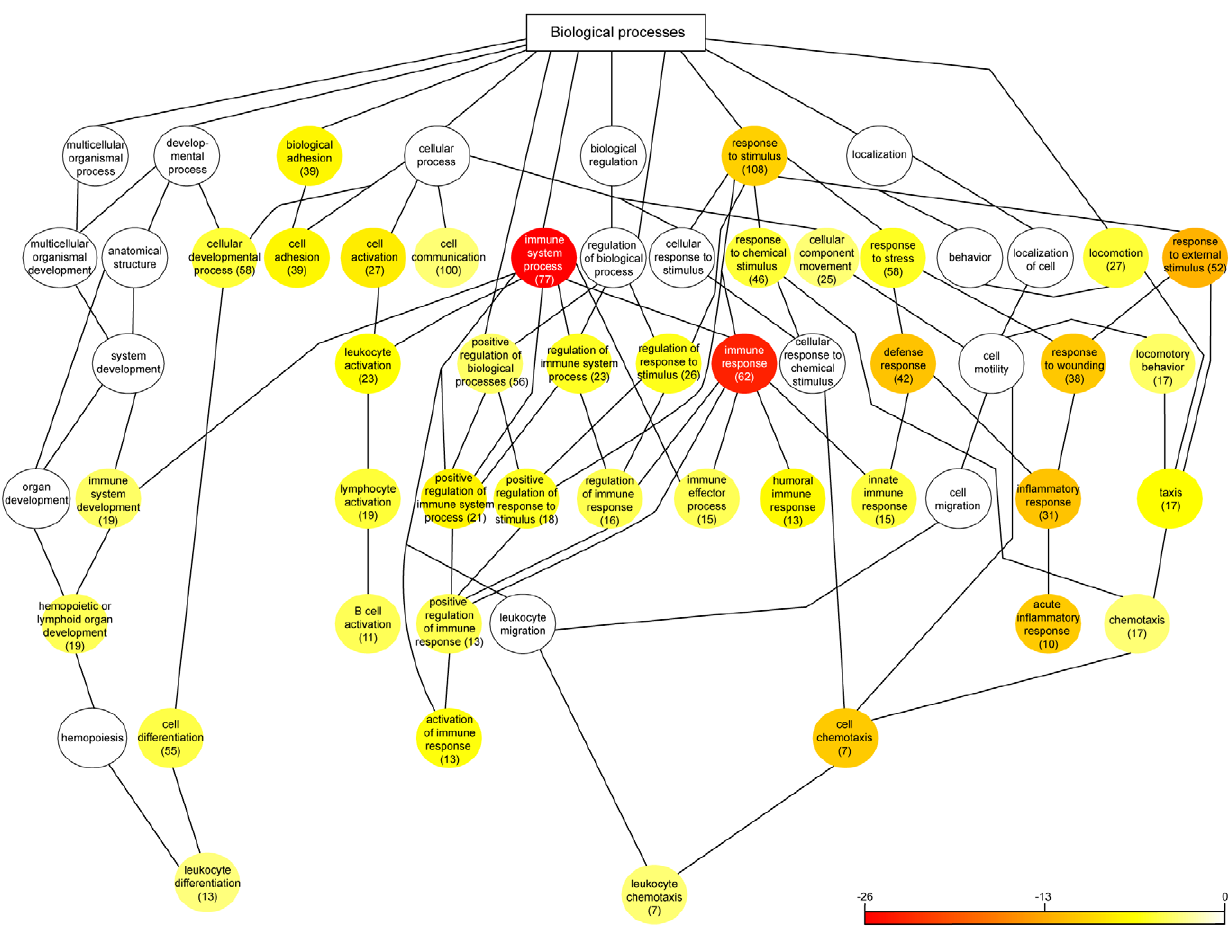
Figure 6. Gene ontology (GO) analysis of differentially expressed genes. All significant ( p , 0.05) Biological processes (GO categories) and their parent terms are shown. The color of each node illustrates the significance and can be interpreted using the scale bar, which displays the p value. Each node is also marked with the number of significantly regulated genes mapped to the GO category.